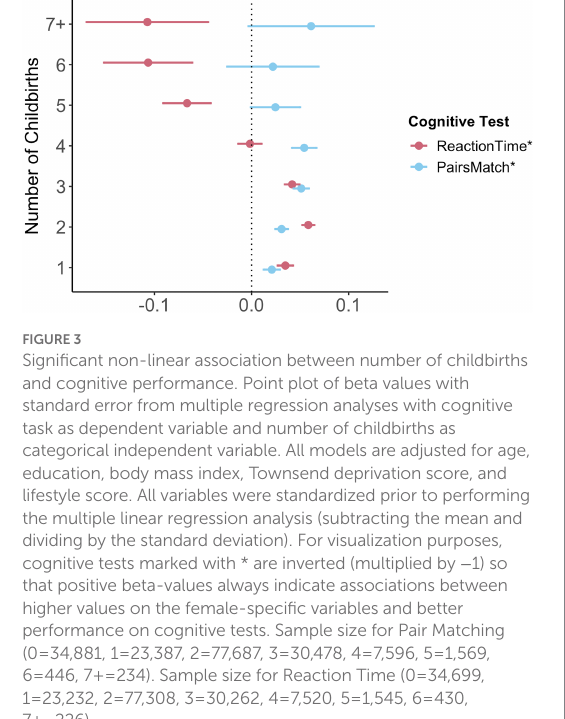
substitution: two ε 4 alleles β = − 0.145, p FDR = 2.39e-06, d = − 0.057;